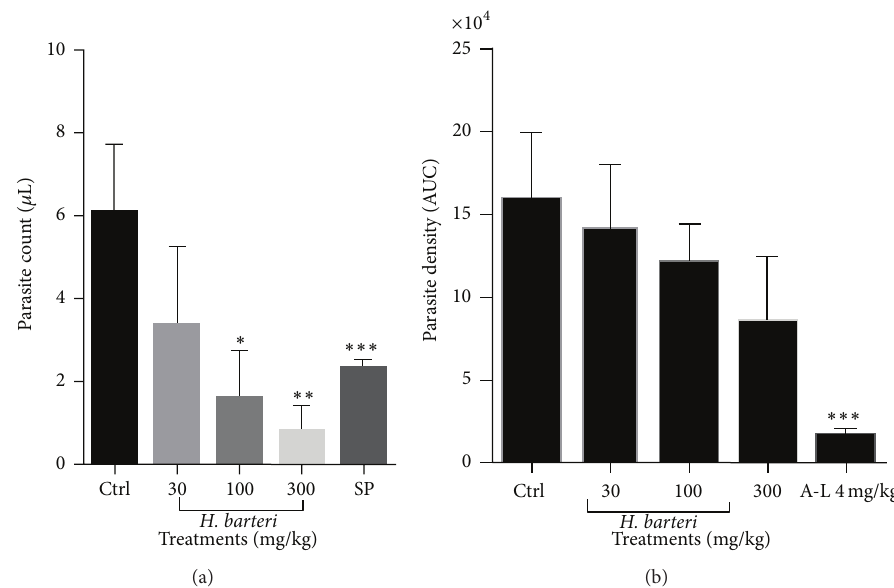
Figure 1: The effect of H. barteri root extract presented as area under the curve (AUC) from the time course curves in (a) the prophylactic and (b) curative malaria tests. Data is presented as mean ± SEM. ∗∗∗ 𝑃 < 0.001 , ∗∗ 𝑃 < 0.01 , and ∗ 𝑃 < 0.05 compared to vehicle-treated group (one-way analysis of variance followed by Tukey’s post hoc